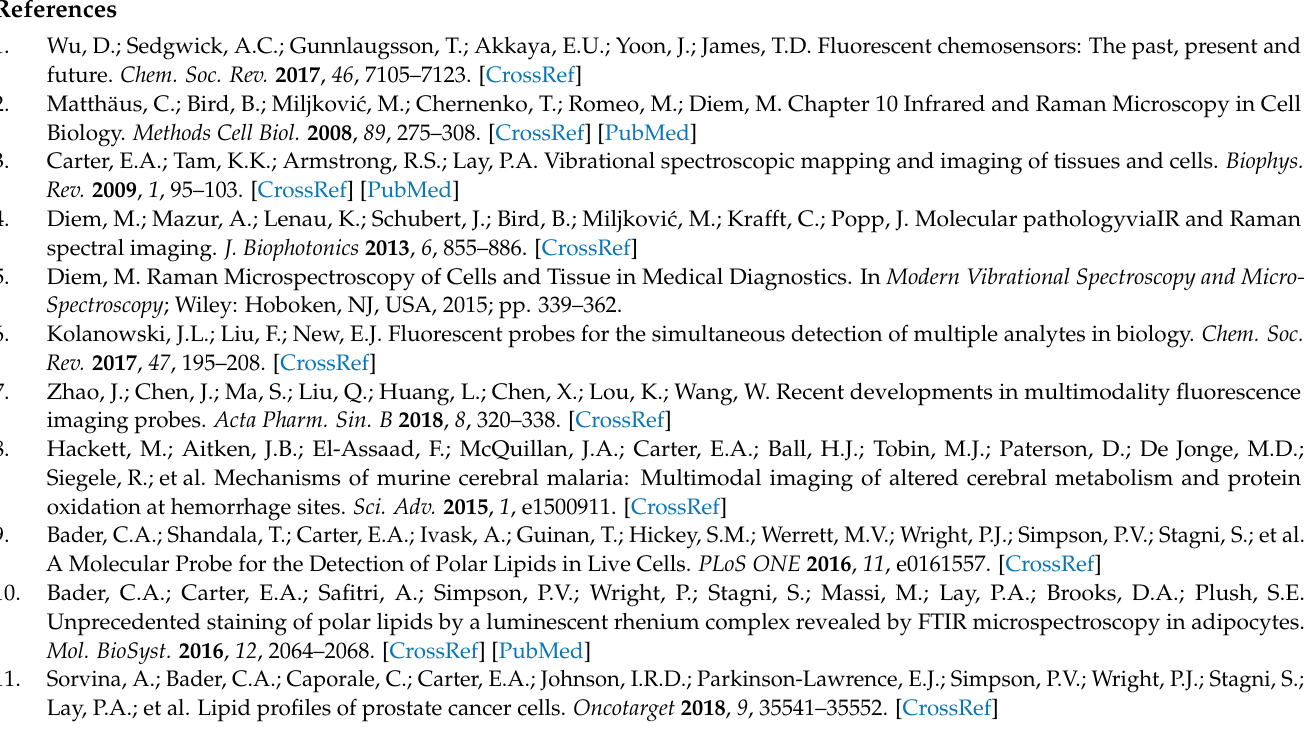
naphthalimide variant; Figure S1: Raman spectrum of alkyne tagged variant 4, in the solid state, taken with the 50X and 785 nm laser excitation; Figure S2: Raw Raman spectrum of NpCN1, in the solid state, taken with the 50X and 785 nm laser excitation. Processed spectrum is seen in Figure 2D; Figure S3: Cell viability of NpCN1 in 3T3-L1 cells; Figure S4: Bimodal cell studies of a representative fixed 3T3-L1 cell dosed with an equivalent volume of DMSO to cells dosed with NpCN1; Figure S5: Principal component analysis of the Raman spectra of a 3T3-L1 cell dosed with an equivalent volume of DMSO to cells dosed with NpCN1; Figure S6: Confocal microscopy images of live 3T3-L1